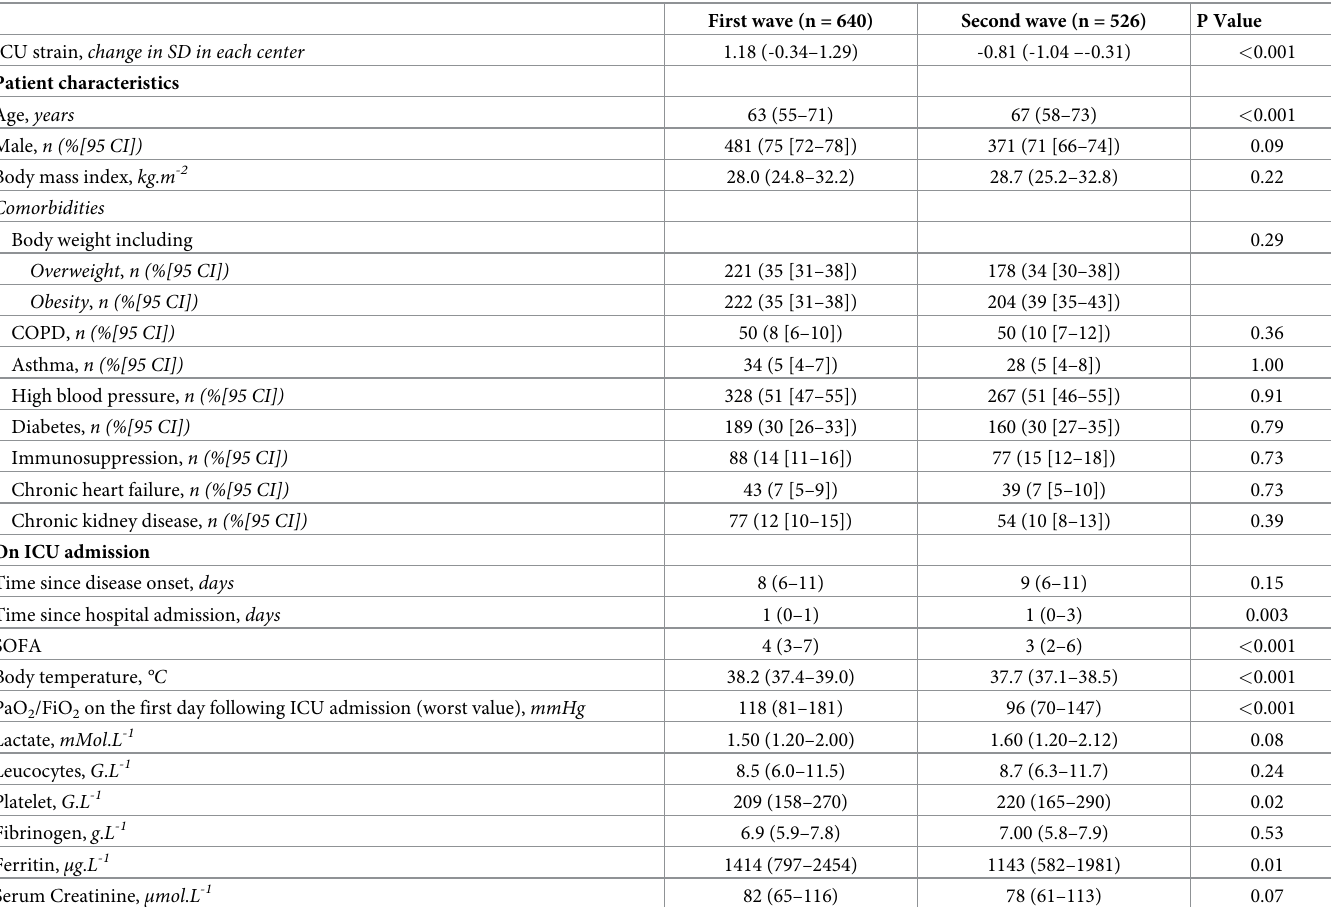
Table 1. Main characteristics at ICU